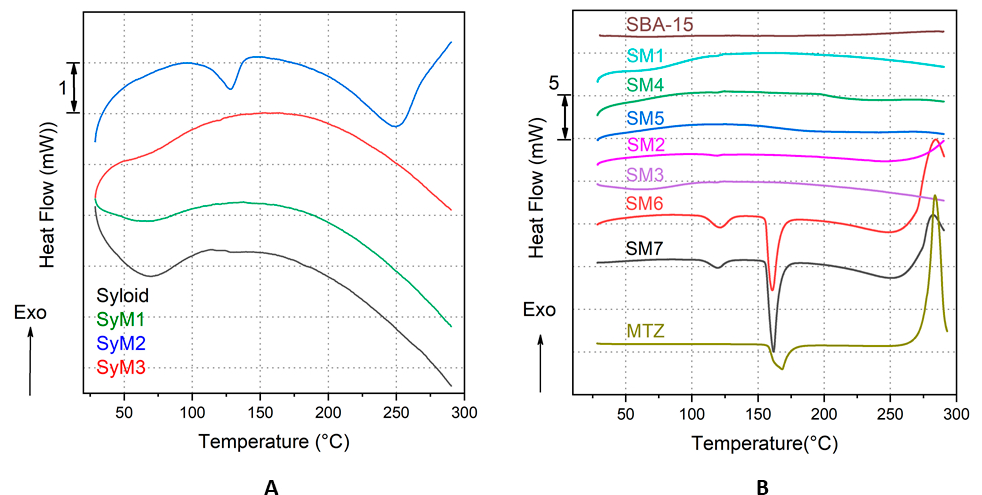
Figure 7. Heat flow (DSC) curves of the Syloid bound MTZ samples and the reference